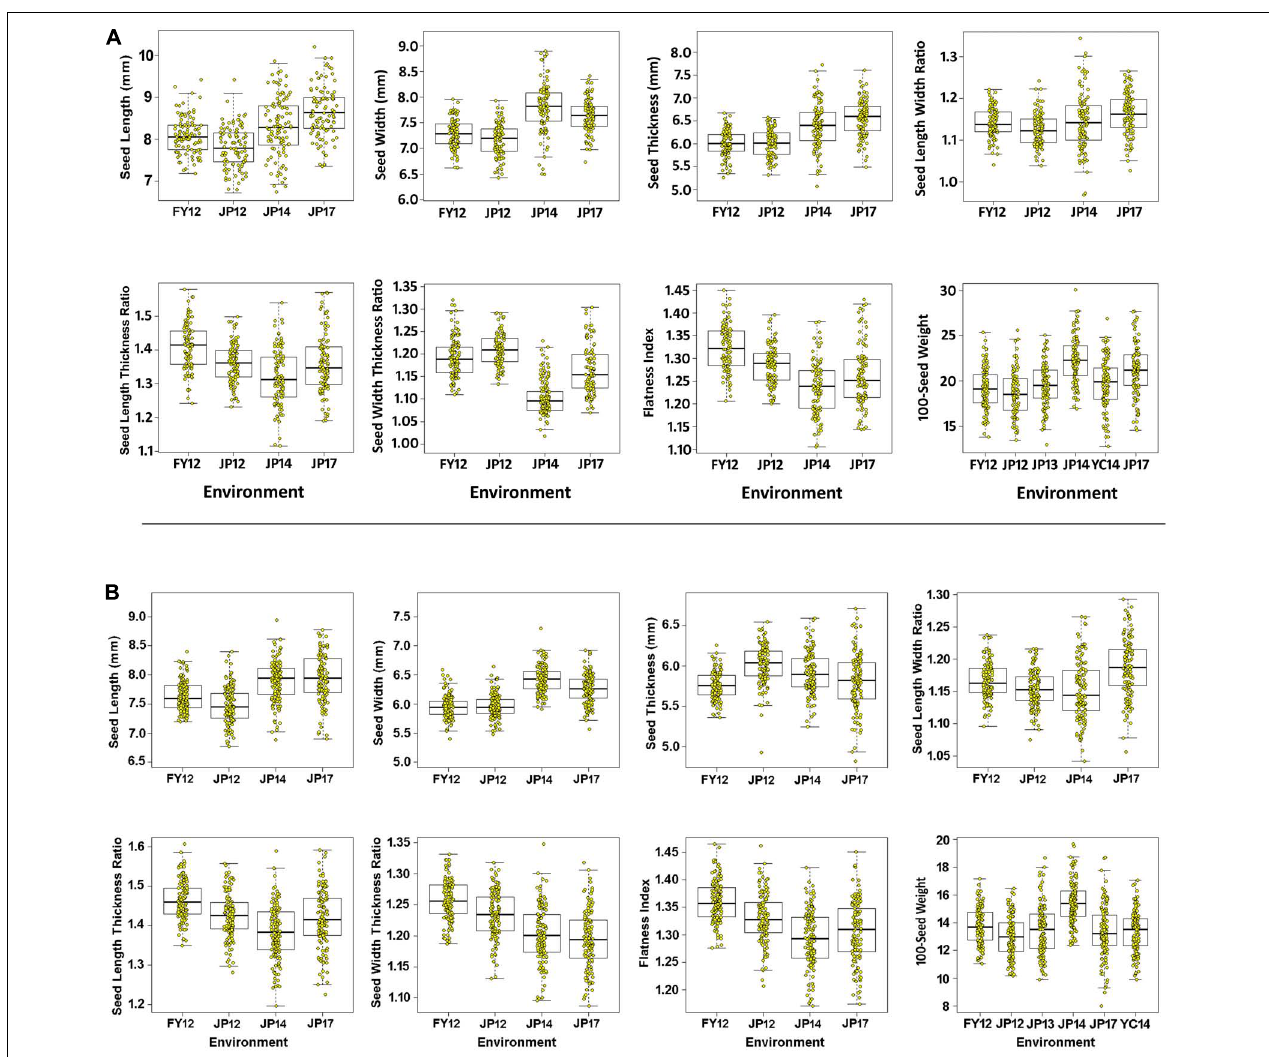
FIGURE 3 | Boxplot for seed size, seed shape, and 100-seed weight traits. The black line in the middle of the box shows the median, the white box indicates the range from the lower quartile to the upper quartile, and the dashed black line and yellow dots represent the dispersion and frequency distribution of the phenotypic data in each of the six environments, i.e., 12FY, 12JP, 13JP, 14JP, 14YC, and 17JP, while (A,B) represent LM6 and ZM6 populations.